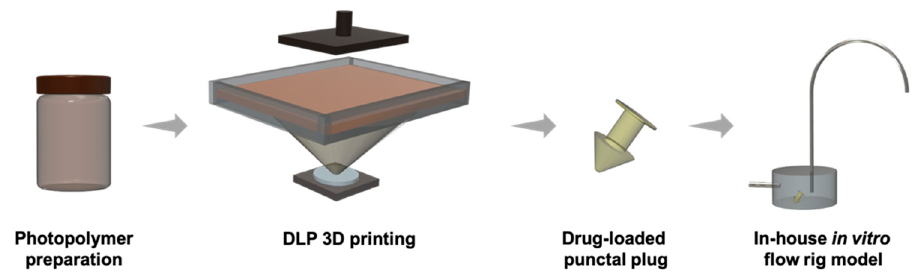
Figure 2. Schematic representation of the DLP 3D printing process and in-house flow rig model for in vitro dissolution studies.